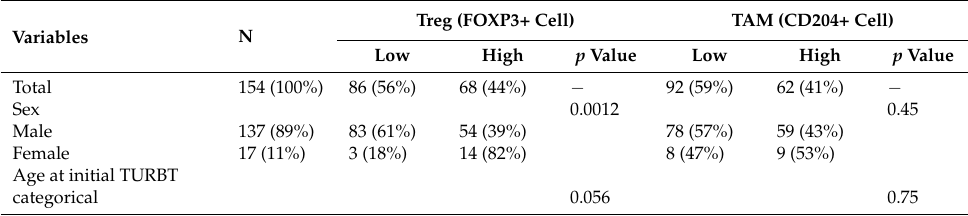
Table 1. Clinicopathologic variables and association with Treg and TAM in primary